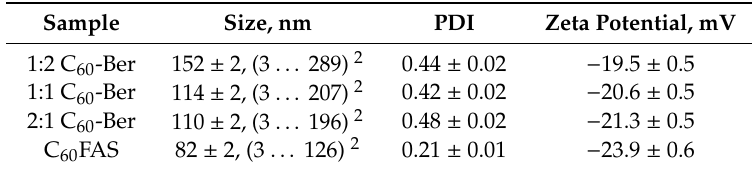
Table 2. The hydrodynamic diameter of particles, polydispersity index (PDI), and zeta potential values 1 for the studied samples at room